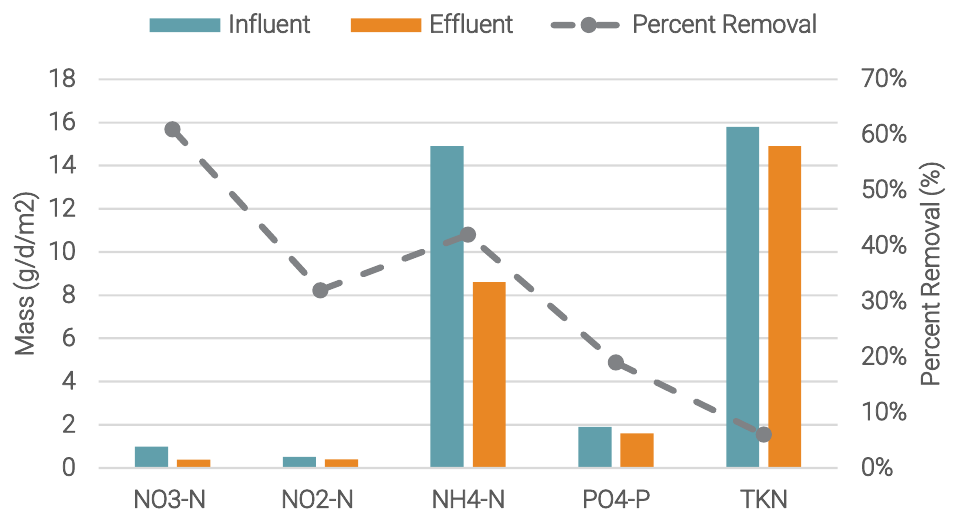
Figure 9. Nutrient percent removal by mass between the influent and effluent (number of samples, 6).